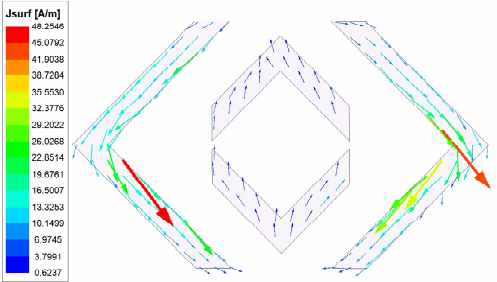
Figure 3. Current distribution of temperature sensor.